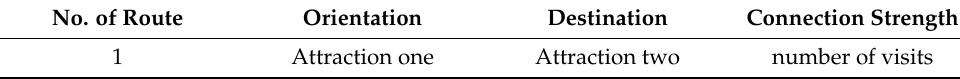
Table 2. The sample of OD.